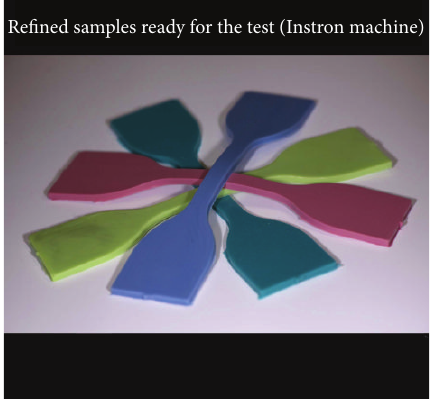
Figure 4: Refined dumbbell test specimens ready for the test (Instron machine).